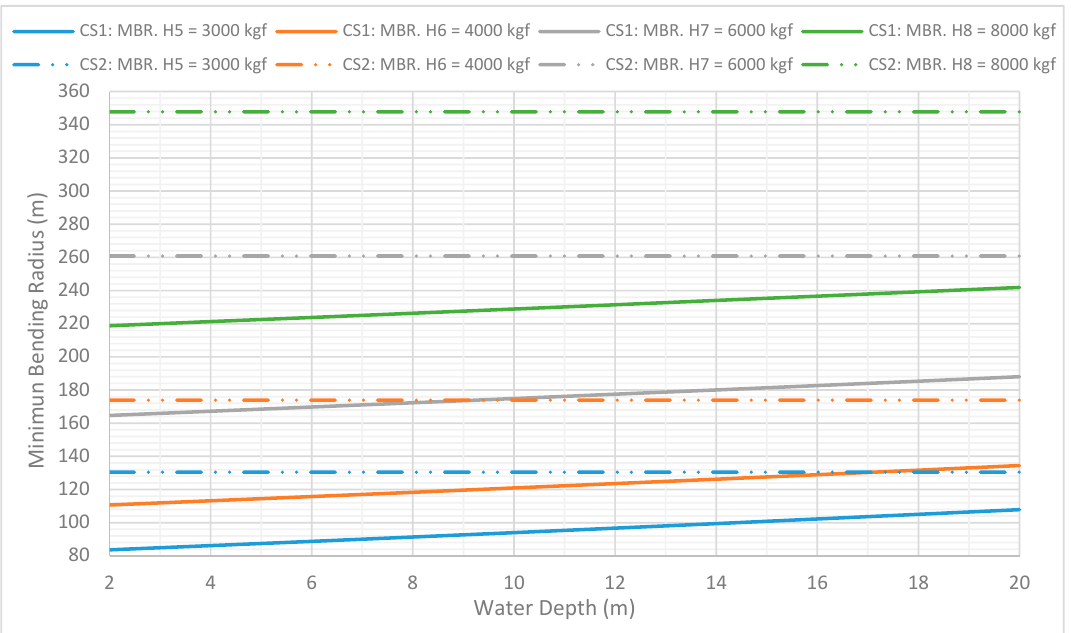
Figure 15. Minimum bending radius assuming CS1 & CS2 using different bottom tensions (3000 kgf–8000 kgf) and water depths (2 m–20 m).